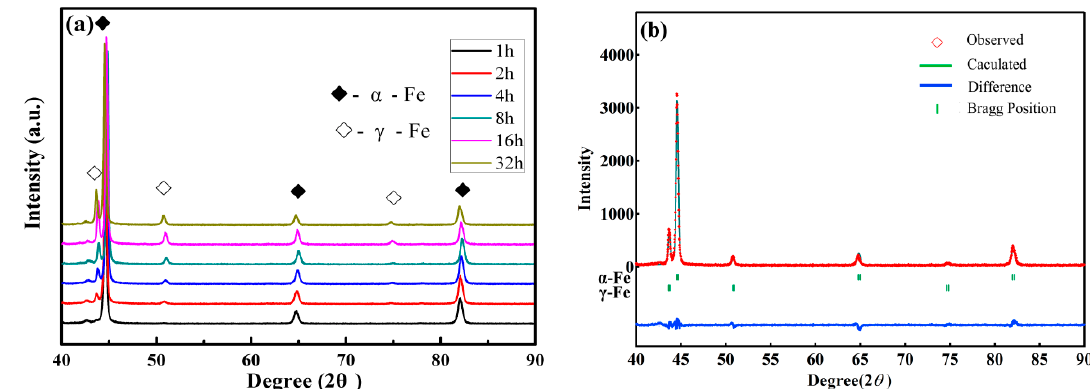
Figure 4. XRD pattern of the samples tempered at 600 °C for different tempering times ( a ) and ( b ) the Rietveld refinement of the sample tempered at 600 °C for 32 h.